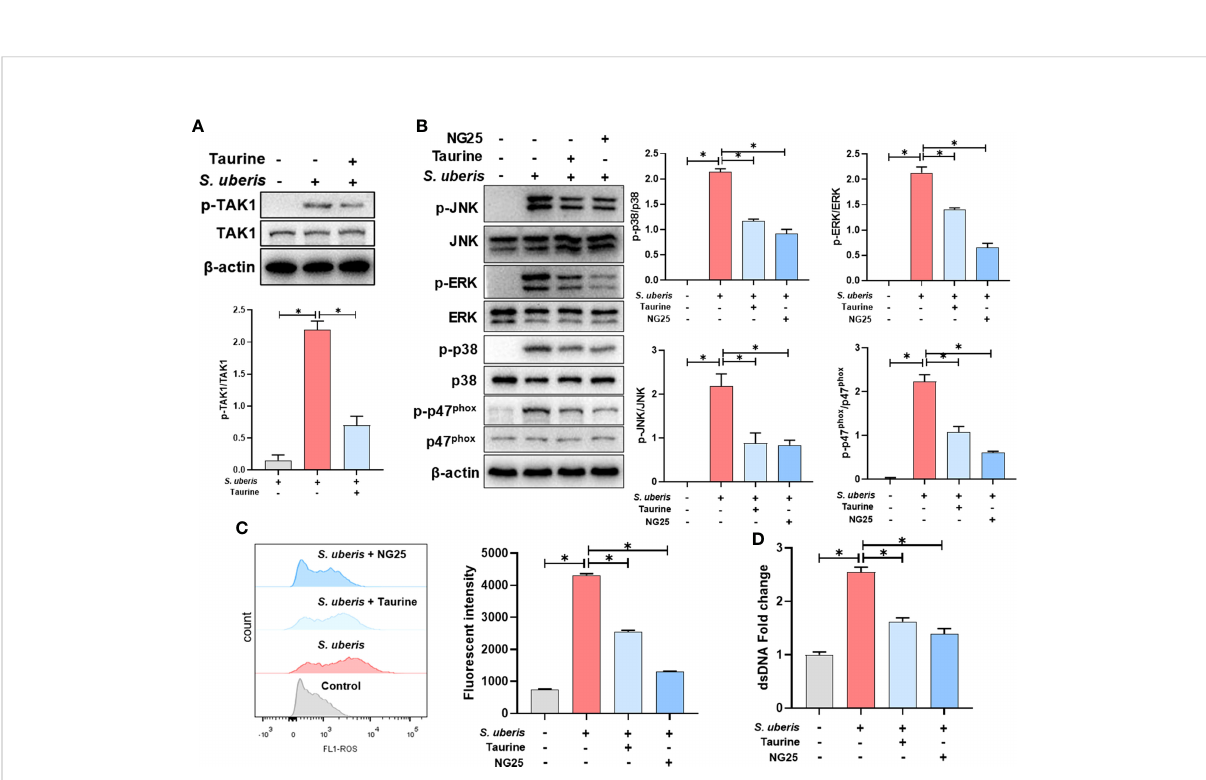
FIGURE 6 TAK1 is critical for the inhibition of MAPK signaling activation and NETs production by taurine in S. uberis infection. The neutrophils were pretreated with taurine (45 mM) or NG25 (40 nM) for 1 h before infected with S. uberis at MOI of 10. (A) Immunoblot and statistical analysis of TAK1 proteins and phosphorylated proteins. (B) Immunoblot and statistical analysis of p38, ERK, JNK and p47 phox proteins and phosphorylated proteins. (C) The Intracellular ROS level evaluated by Flow Cytometry. (D) The dsDNA content in supernatant. Data are presented as mean ± SEM (n = 3). * P < 0.05.